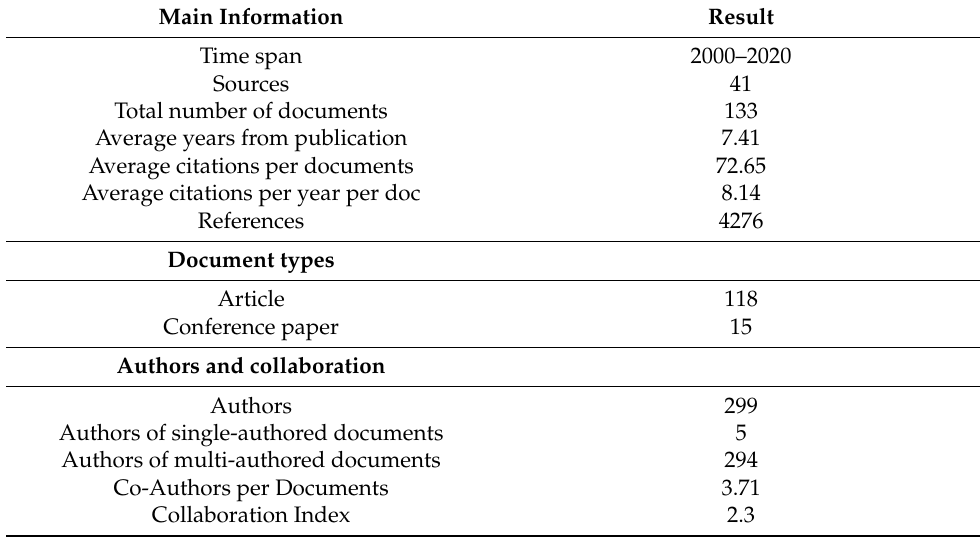
Table 1. Summary bibliometric statistics of the relevant publications on hyperspectral image pro- cessing for anomaly detection in remote sensing applications acquired by the presented search strategy (Figure